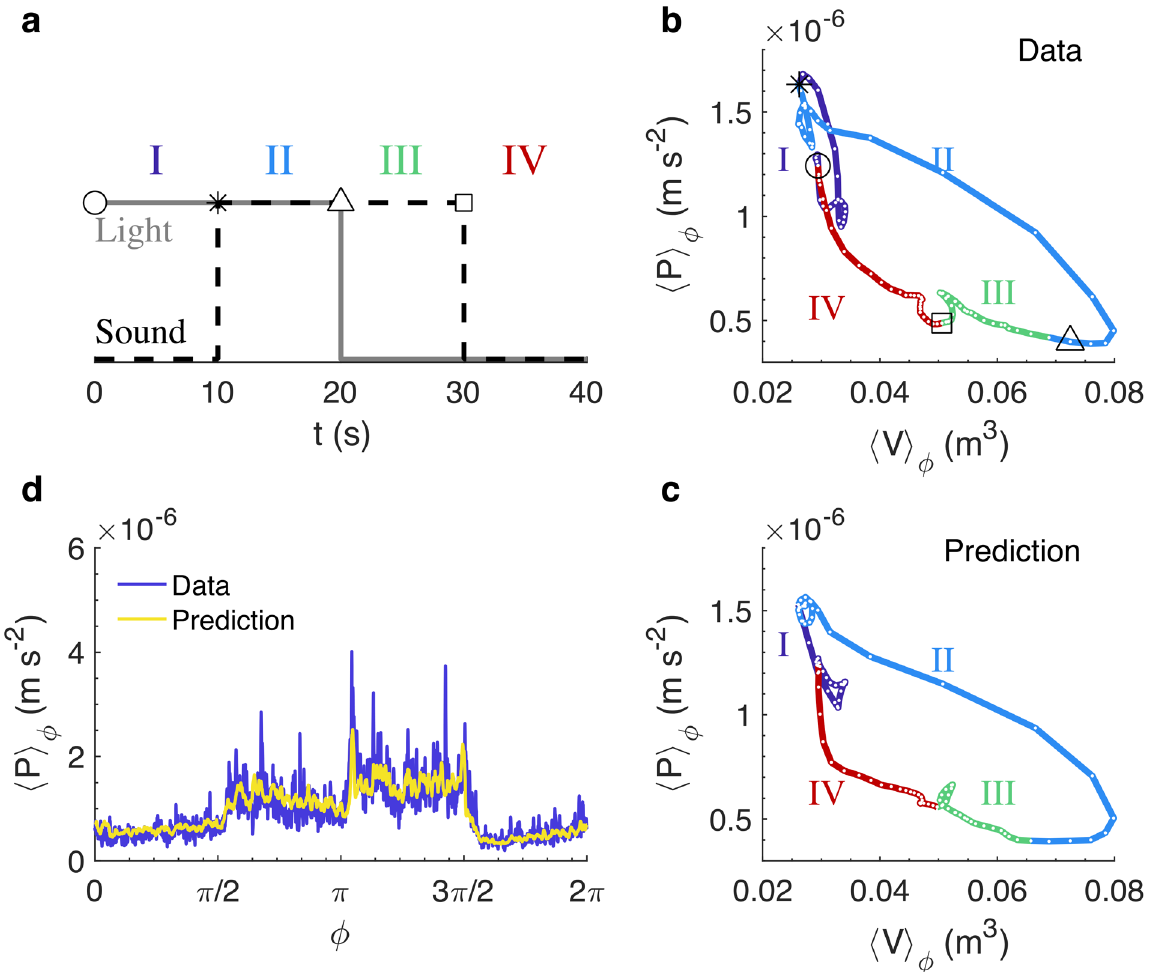
Figure 3. Thermodynamic cycling of a midge swarm with � N � = 27 . Schematic of the perturbation cycle showing the illumination (solid) and sound (dashed) signal timings. The symbols indicate the switching points identified in ( b ). ( b , c ) Phase-averaged swarm behaviour during the perturbation cycle plotted in the pressure– volume phase plane for ( b ) the pressure signal as measured and ( c ) as reconstructed using our equation of state. (cid:31) (cid:30) φ denotes a phase average of a quantity over a full cycle. The four different states of the perturbation signal are indicated. The data has been averaged using a moving 3.5-s window for clarity. The swarm behaviour moves in a closed loop in this phase plane during this cycling, as would be expected for an engine in equilibrium thermodynamics, and the equation of state holds throughout even though it was developed only for unperturbed swarms. ( d ) Phase-averaged pressure (cid:31) P (cid:30) φ of the swarm during a continuous cycle through the four light and sound states. The blue line shows the directly measured pressure and the yellow line shows the reconstruction using the equation of midge enclosure, and were arranged in a horizontal plane with angular separations of 30° and 70° 23 and placed far enough from the experimental enclosure to ensure that the full swarm was always fully within the field of view of each camera. Calibration of the imaging system was done via Tsai’s method 34 , using a flat plate with a regular dot pattern placed inside the tank (and removed before the initiation of swarming) as a calibration reference. During each acquisition session, each of which typically occurred on different days, we recorded between 30,000 and 100,000 frames of data, corresponding to 5–16 min and 40 s of swarming. To obtain three-dimensional trajectories from the individual camera recordings, we first processed each image to obtain 2D midge positions in each camera’s frame of reference, matched the data between the cameras to obtain 3D midge positions for every midge in the swarm, and finally tracked all the 3D positions in time. The observed swarms are dilute. Even in statistically unusual cases of close midge encounters, individuals can still be identified 23 . To process the images, we first removed the background illumination field (obtained by averaging over the full image sequence) and then detected midges simply by computing the centroids of connected regions that were brighter than an empirically set threshold and larger than a minimal pixel size. Regions that were highly non-spherical and very large indicated the overlap of the images of multiple midges in the camera’s field of view, and so were split into multiple midges (see Ref. 23 ). The 2D midge coordinates were stereo-matched between the cameras by projecting the lines of sight connecting each camera’s centre of projection and each midge’s 2D location into 3D space using